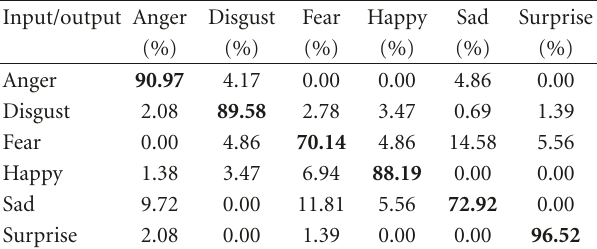
Table 4: Confusion matrix of the LDA classifier for the manually selected landmarks.